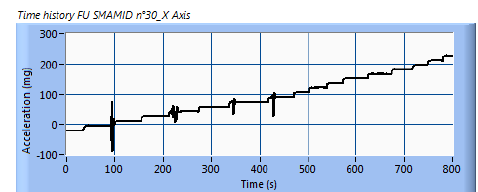
Figure 7. Time history for FU SMAMID n°30 x axis during zenith angle variation from 300 to 284